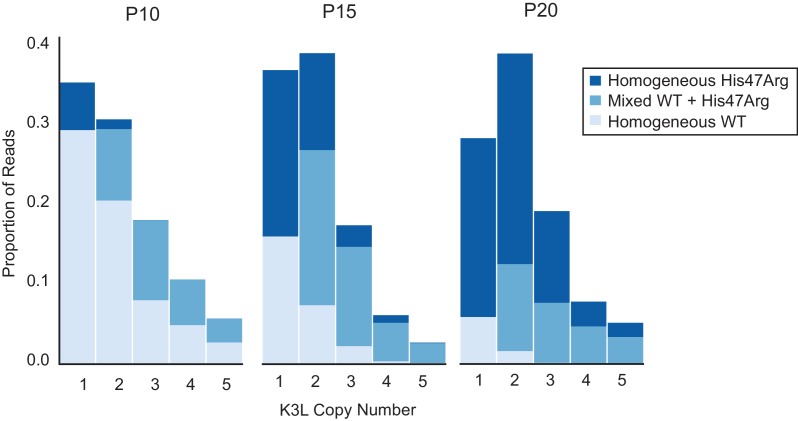
Simulated accumulation of the K3LHis47Arg SNV.The K3LHis47Arg allele was uniformly distributed in simulated vaccinia populations with copy number distributions identical to passages P10, P15, and P20 (see Materials and methods for further detail). Stacked bar plots representing the proportions of mixed and homogeneous K3L arrays were generated as in Figure 3.